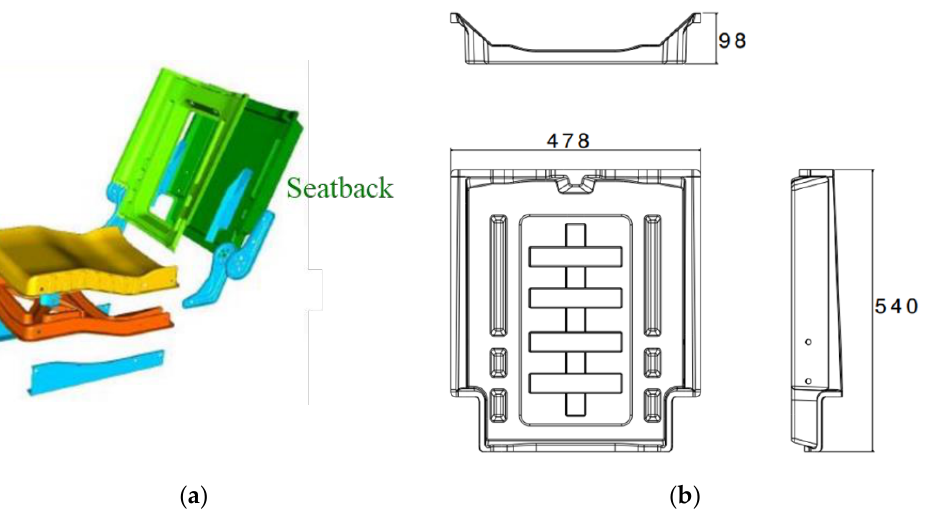
Figure 20. LFT-D Automotive Seatback: ( a ) as part of the assembly, ( b ) overall dimensions [mm].